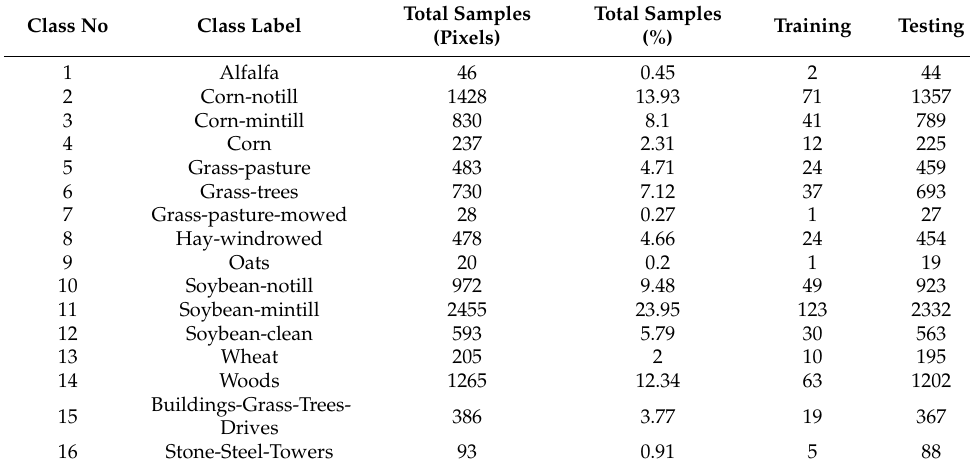
Table 1. Per Class information for IP dataset.